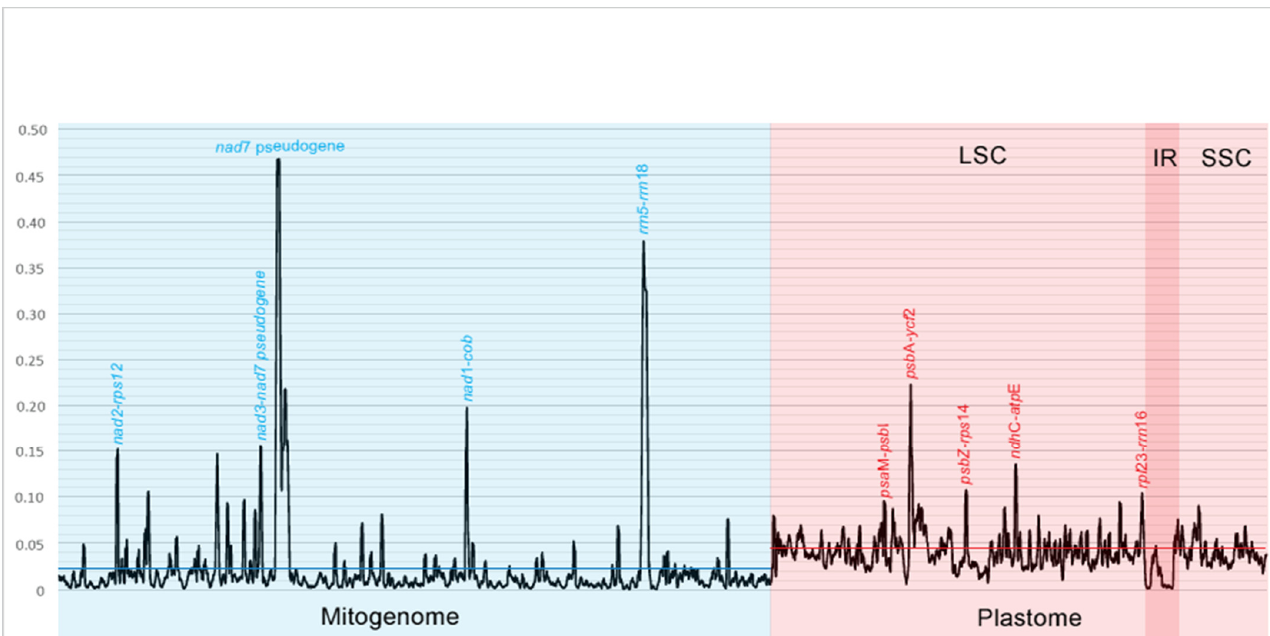
Figure 1. The five most variable regions in plastome and mitogenome of Calypogeia obtained by 500 bp-long sliding window. The chart shows the π values.